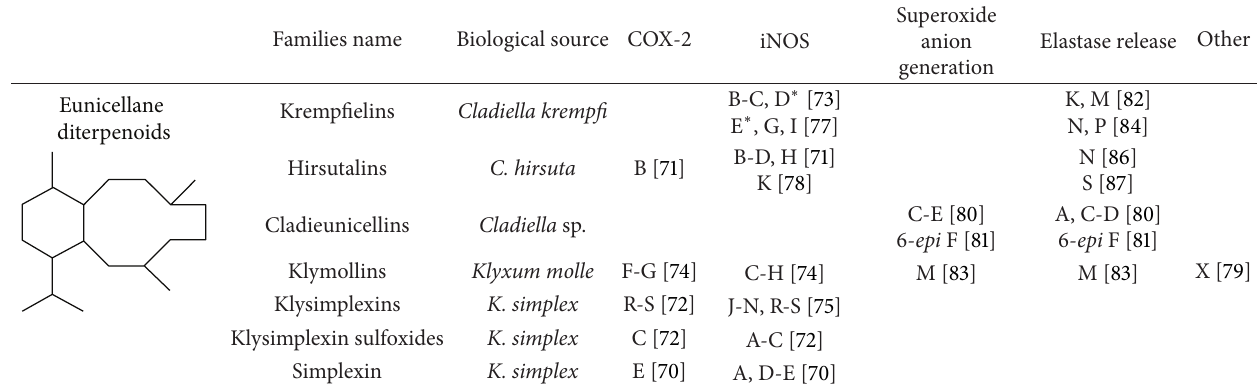
Table 1: Anti-inflammatory effect of eunicellane